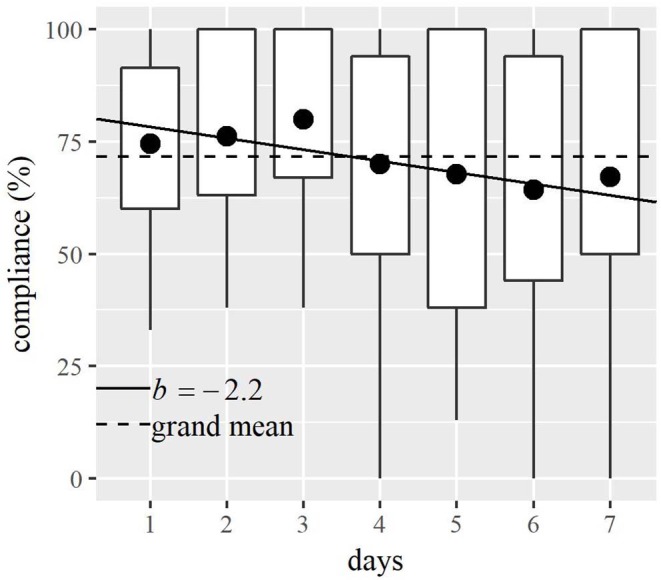
Relationship between patients' compliance (i.e., relative proportion of answered prompts to received prompts) and testing day. The dots show the mean compliance on each testing day. The lower and upper portions of the boxes correspond to the first and third quartiles. The lines leading the boxes indicate the range of compliance. The solid line shows the relationship between compliance and testing day. The broken line indicates that the mean compliance was 71.6% over the entire course of the study.